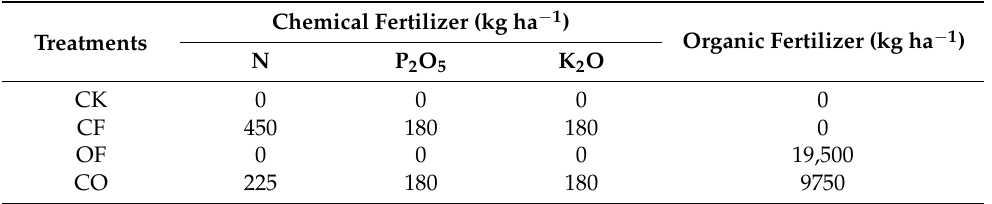
Table 1. Fertilizer application rate of each